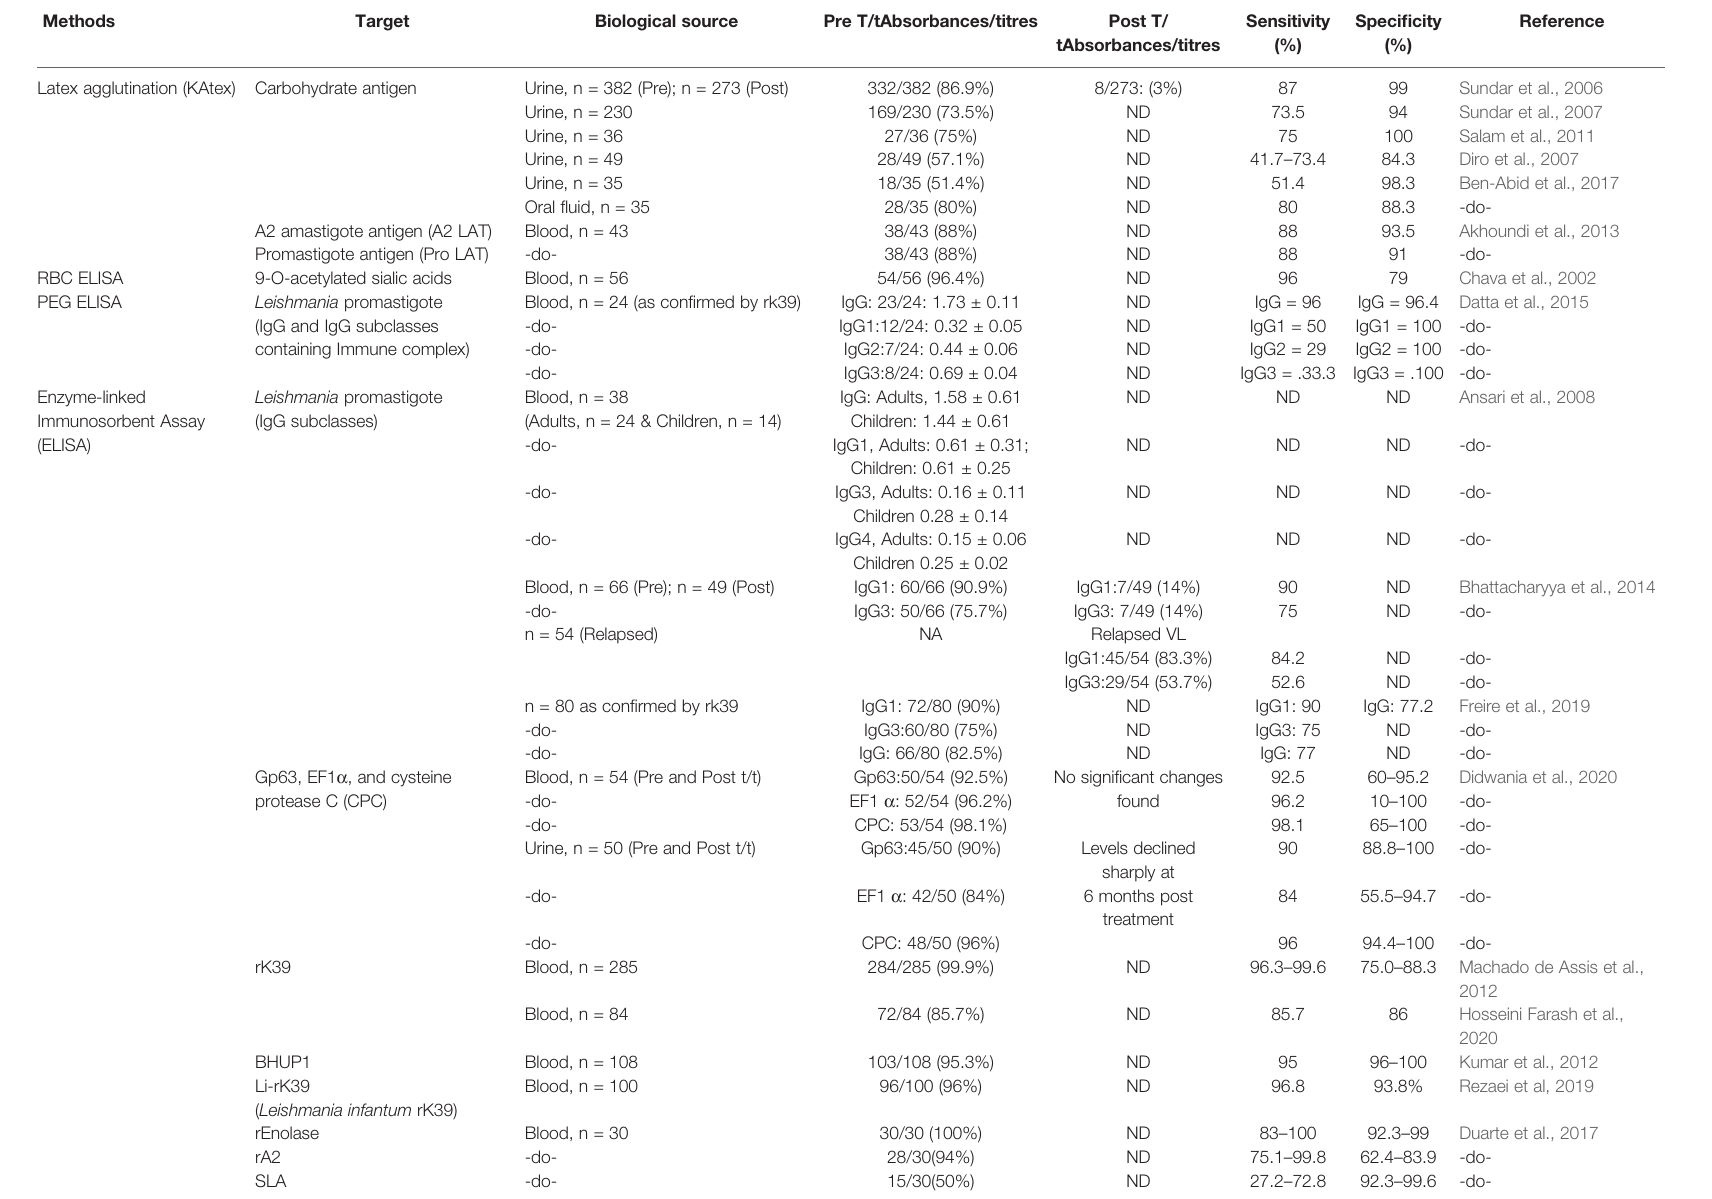
TABLE 1 | Antigen/Antibody Markers of